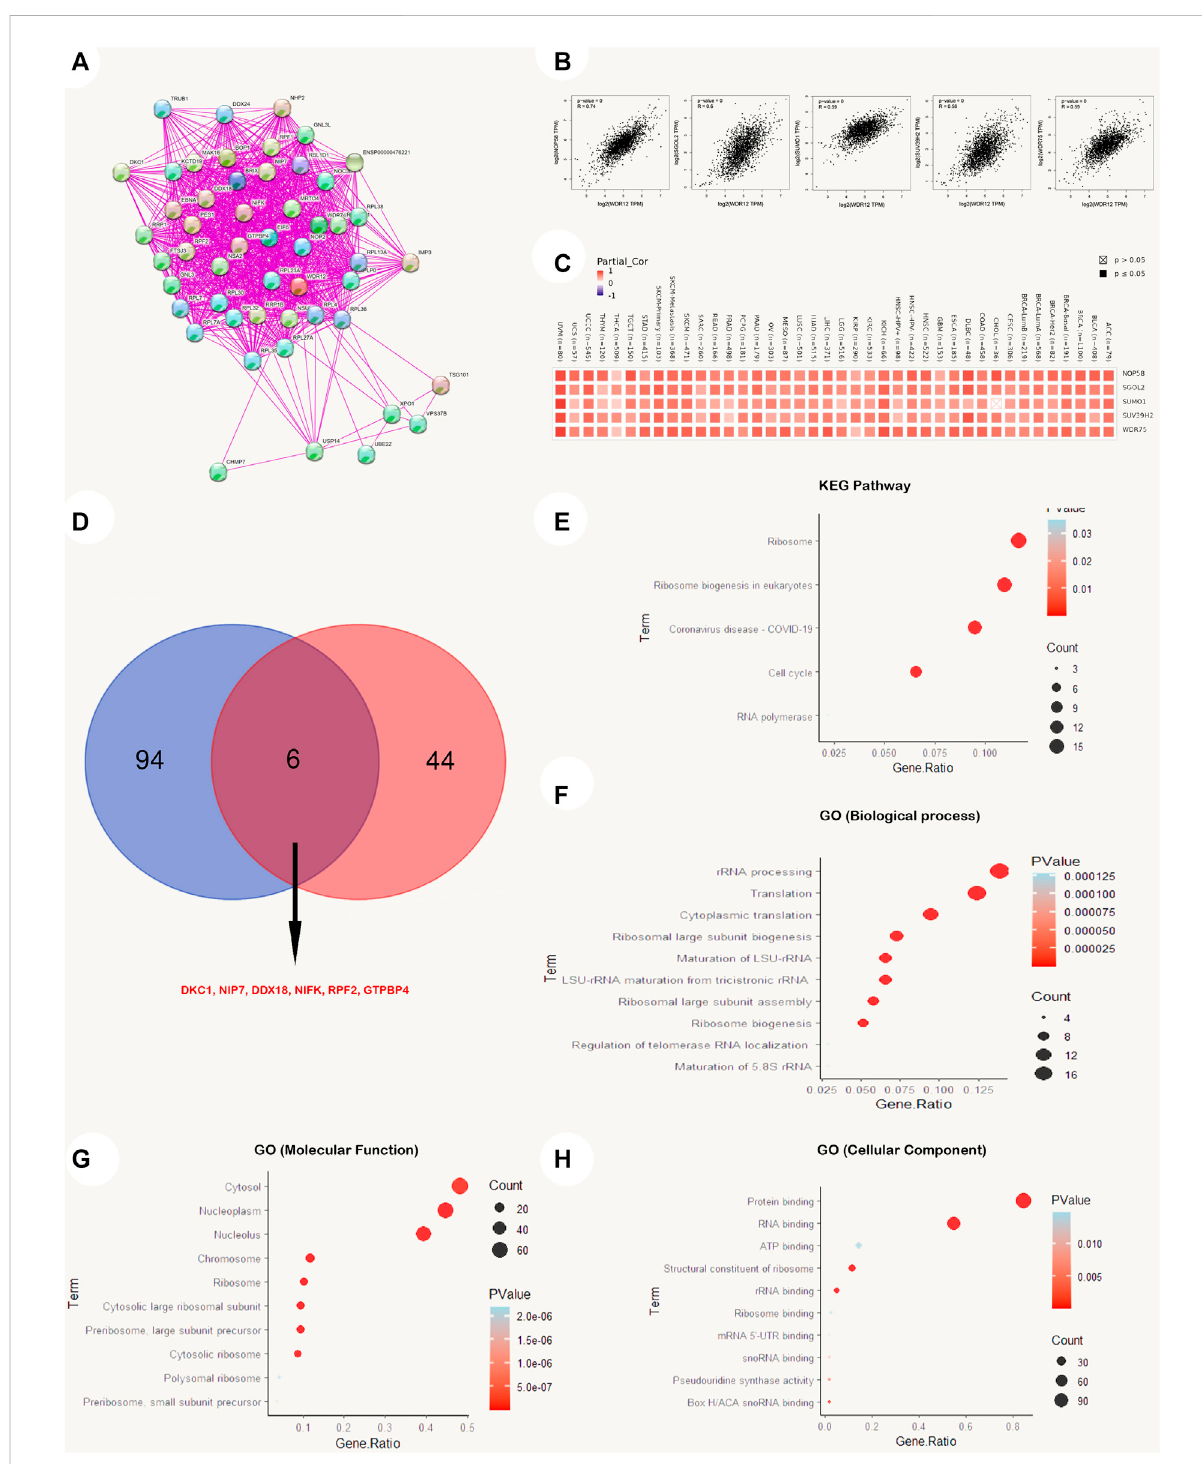
FIGURE 9 WDR12-protein network interactions. (A) A map of top 50 WDR12 interacting proteins as determined by STRING database; (B) expression correlation between WDR12 and genes (NOP58, SGOL2, SUMO1, SUV39H2 and WDR75) as determined by GEPIA2; (C) heatmap for top 5 WDR12- correlated proteins in the tumor tissue; (D) Venn diagram showing the intersection between WDR12 interacting and correlating proteins; (E – H) KEGG/GO enrichment analysis based on WDR12-binding and interacted